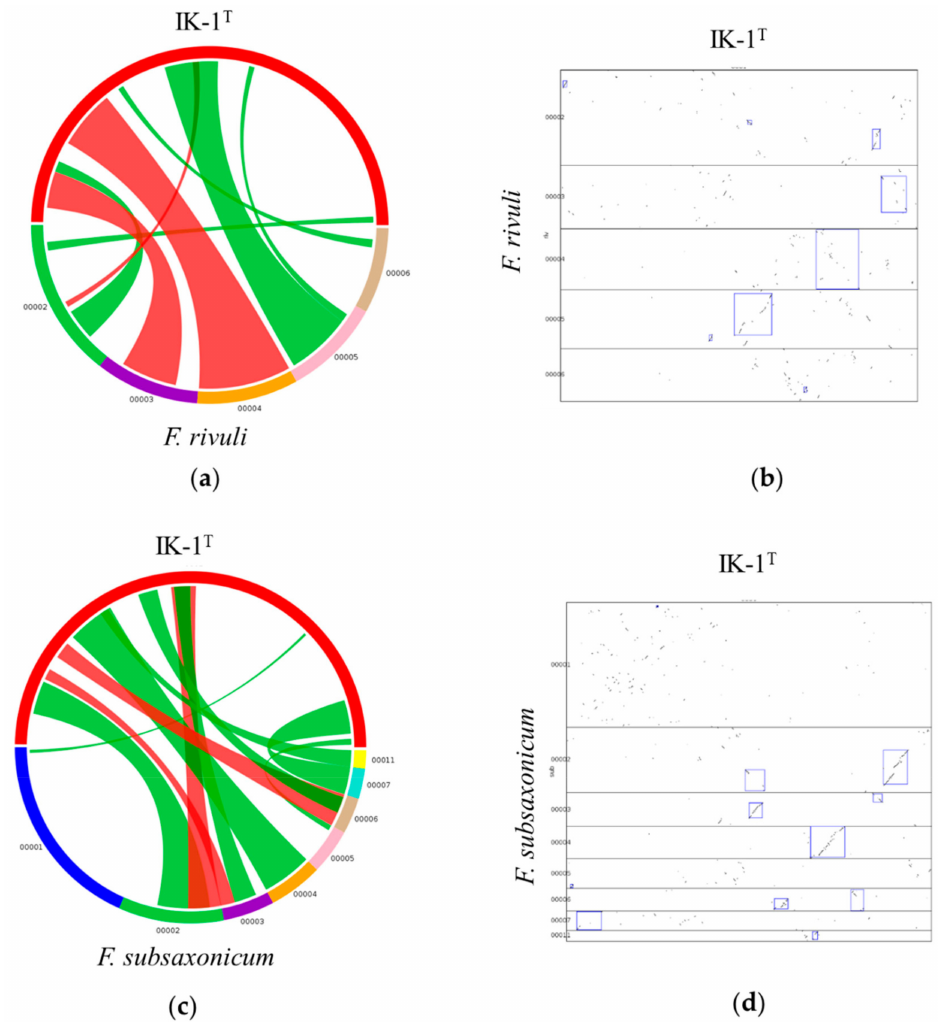
Figure 4. Syntenic blocks shared between IK-1 T and its nearest phylogenetic neighbors. ( a ) Syntenic blocks shared between IK-1 T and F. rivuli . ( b ) Syntenic regions shared between IK-1 T and F. rivuli visualized by dotplot. ( c ) Syntenic blocks shared between IK-1 T and F. subsaxonicum . ( d ) Syntenic regions shared between IK-1 T and F. subsaxonicum visualized by dotplot. Red: forward synteny, green: reverse synteny. Red in the circle: IK-1 T , other colors in the circle: sca ff olds of F. rivuli ( a ) or F. subsaxonicum ( c